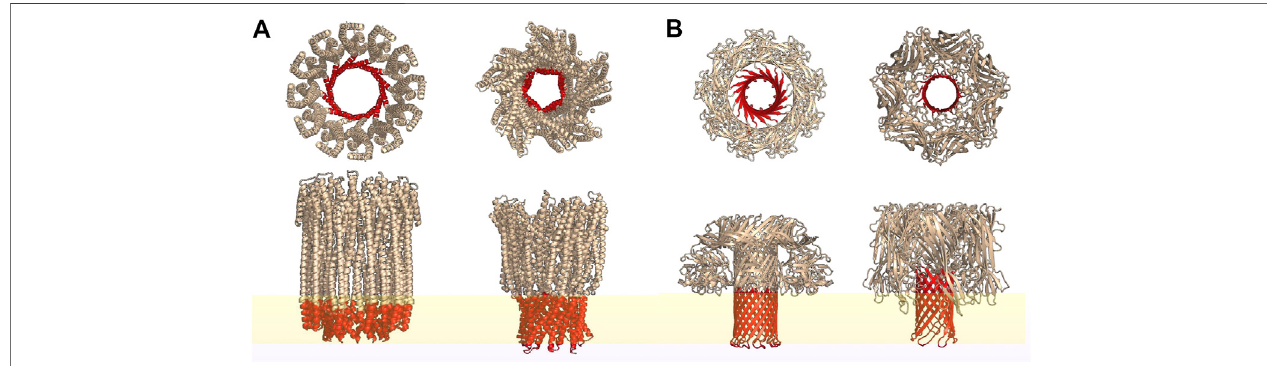
FIGURE 1 | Top and side view representations of some typical α -PFTs (A) and β -PFTs (B) reconstructed from the PDB structures using PyMOL. Regions highlightedinredrepresentthetransmembranespanningsecondarystructureswhileyellowrepresentsalipidbilayer.Fromleft:cytolysinA(PDBid:6MRT);AhlBporeof AHL, from Aeromonas hydrophila ; lysenin (PDB id: 5GAQ) and hemolysin (PDB id: 7AHL).